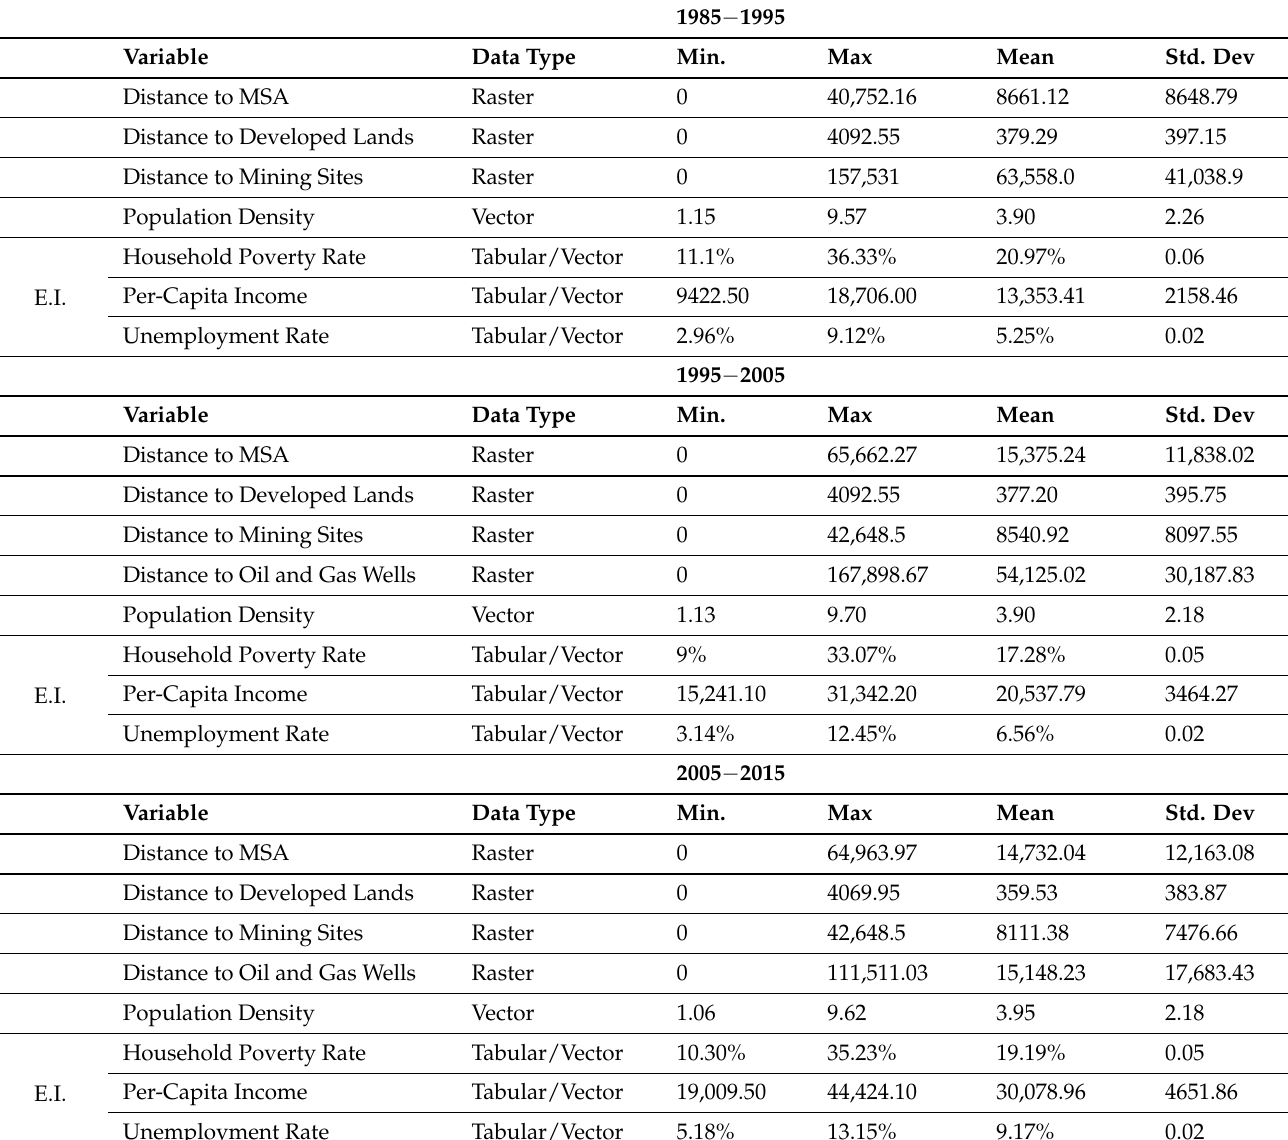
Table 2. Summary Statistics of the